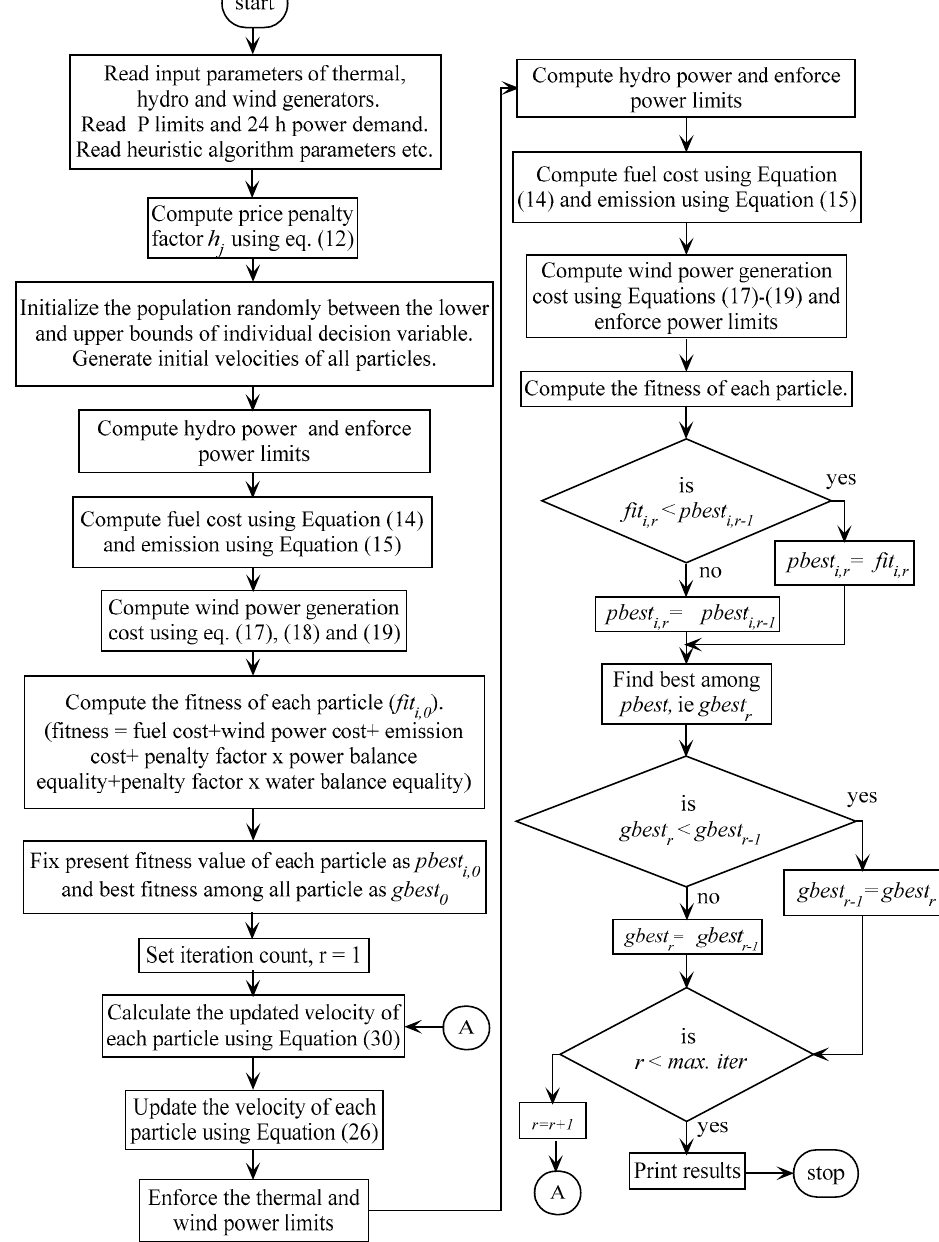
Figure 1. Flow chart of the proposed MPSO method.